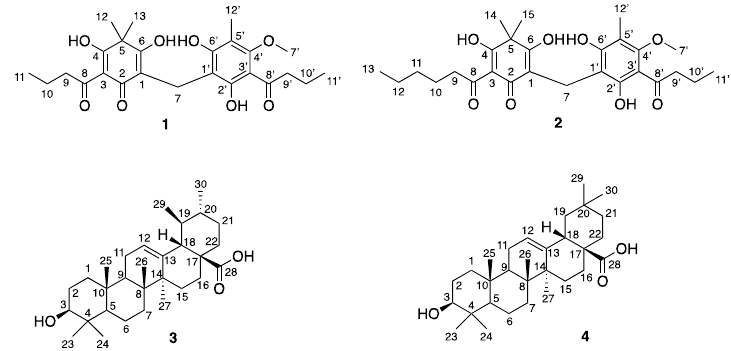
Figure 1. Structure of the compounds isolated from Psiloxylon mauritianum.